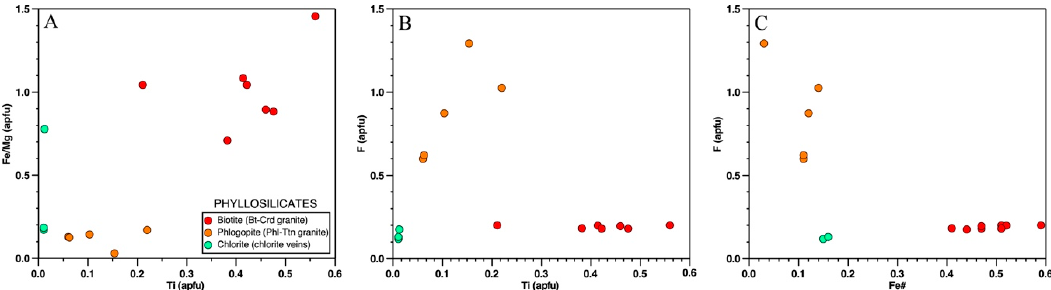
Figure 6. ( A, B, C ) Compositional diagrams for selected elements in biotite from a cordierite ‐ biotite Figure 6. ( A – C ) Compositional diagrams for selected elements in biotite from a cordierite-biotite granite, phlogopite from a phlogopite ‐ titanite granite, and chlorite from endoskarn bodies. granite, phlogopite from a phlogopite-titanite granite, and chlorite from endoskarn